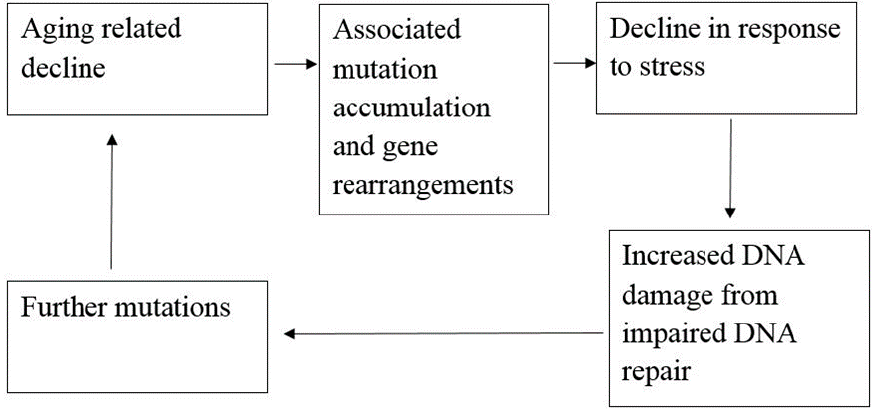
Figure 2. The cycle of aging-related decline and genetic instability (adapted from reference [56]).